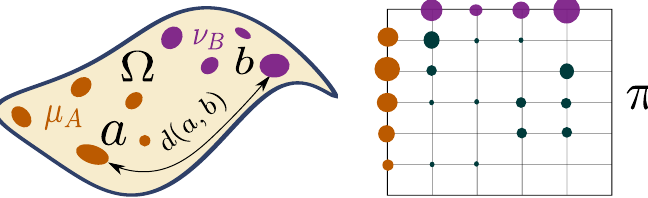
Figure 5. Example of a coupling between two discrete measures on the same ground space equipped with a distance d that will define the Wasserstein distance. ( Left ): the discrete measures on Ω . ( Right ): one possible coupling between these measures that conserves the mass. Image adapted from [21] [Figure